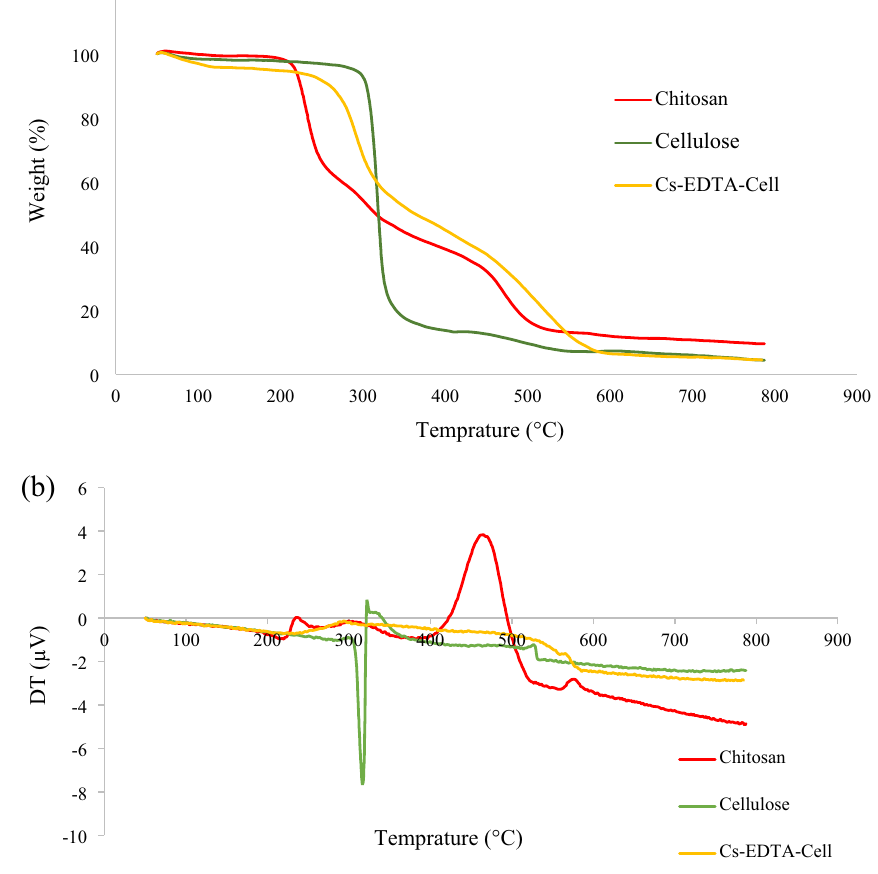
Figure 4. TGA ( a ) and DTA ( b ) curves of chitosan, cellulose and Cs-EDTA-Cell network ( 1 ).